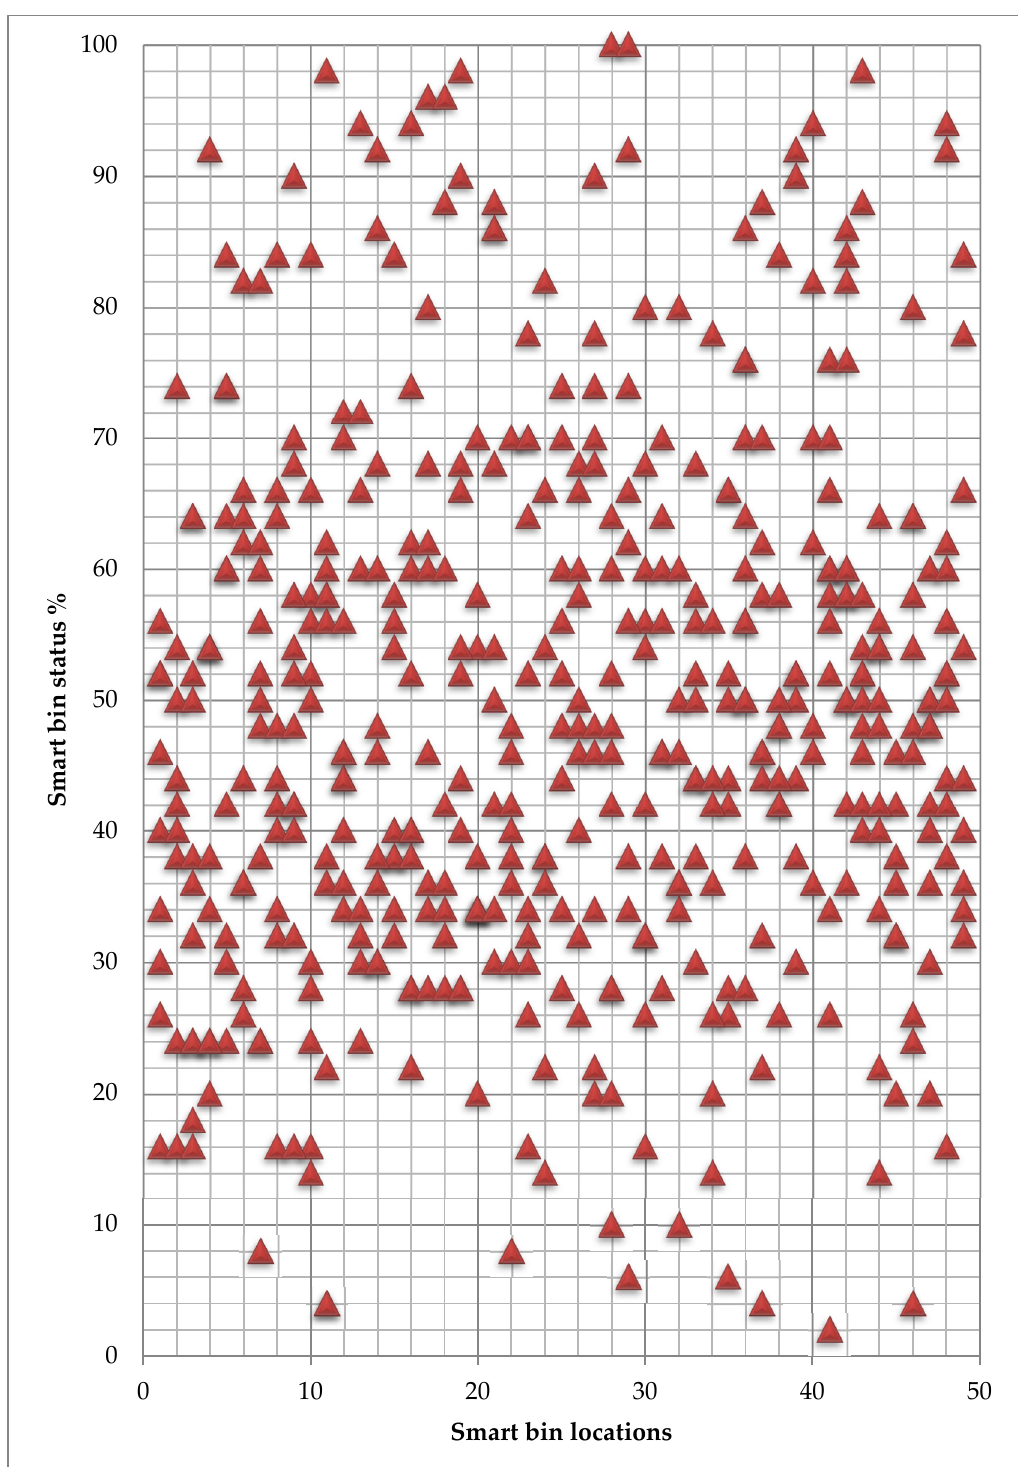
Figure 19. Smart bin status towards each smart bin location-Type 2.